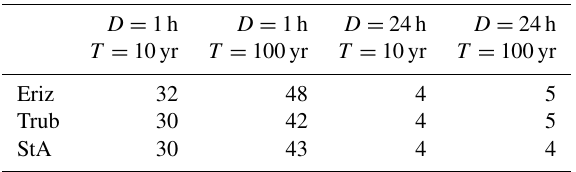
Table 5. Rainfall intensity [mmh − 1 ] for specific durations and re- turn periods, used to define the boundaries in the sensitivity analy- sis. D denotes duration; T denotes return